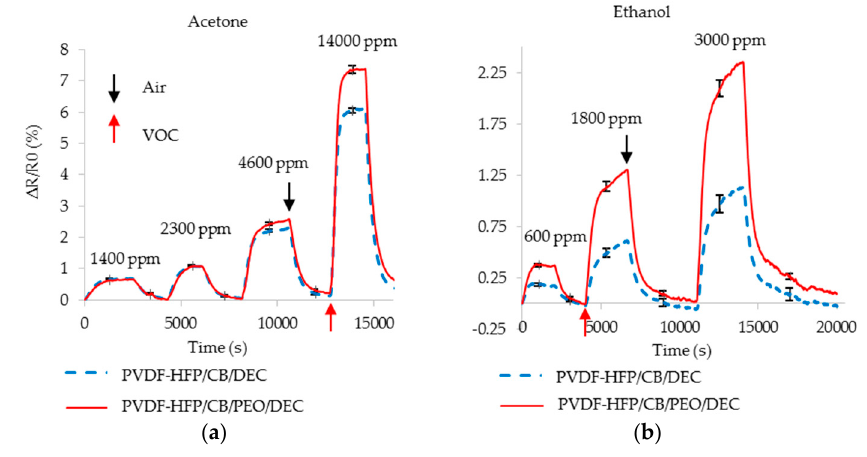
Figure 12. Resistance change of PVDF-HFP/CB film after addition of DEC (dotted blue) is compared with addition of PEO/DEC (solid red) at various concentration of ( a ) acetone; ( b ) ethanol.